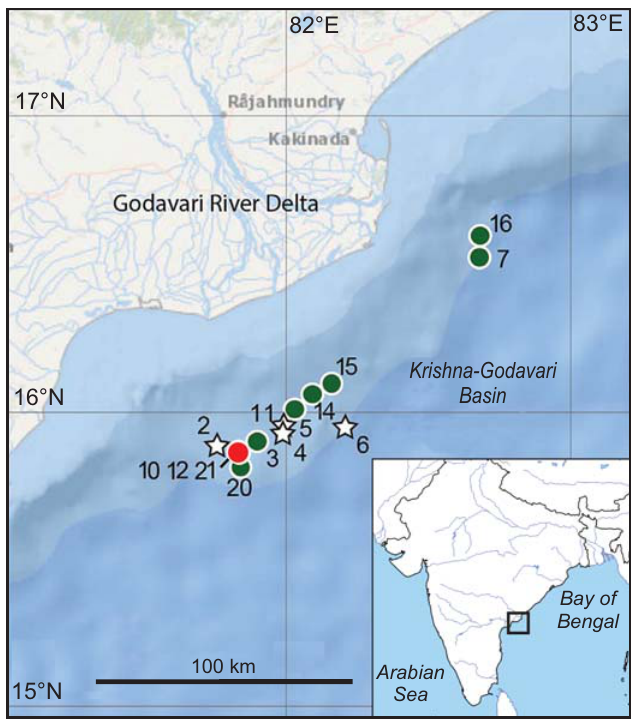
Fig. 1. NGHP-01 core sites (circles) and logging sites (stars) in the offshore Krishna-Godavari Basin, modified from Lorenson and Collett (2018). Site 12 is co-located with sites 10 and 21 (red circle). Inset shows the study area in Krishna-Godavari Basin is located on the eastern margin of penin- sular India in the western Bay of Bengal.